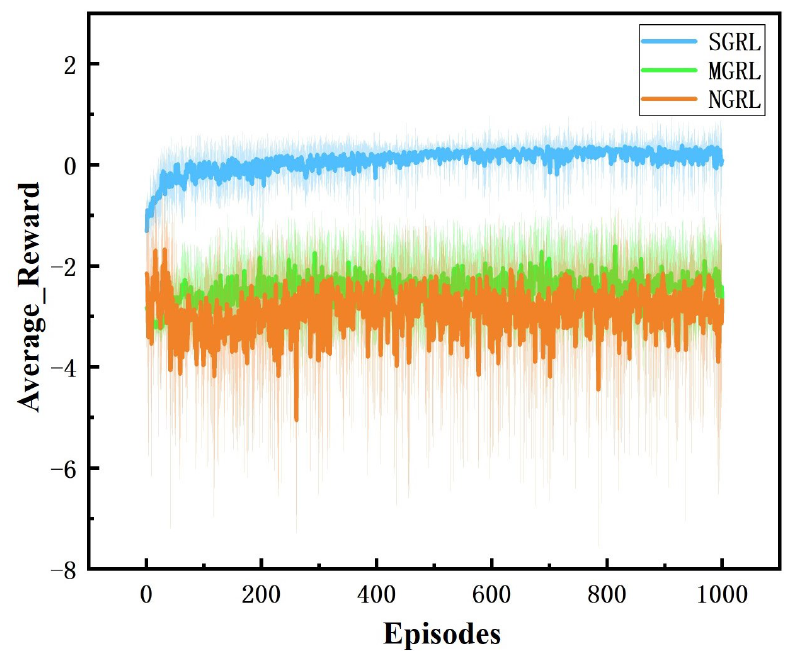
Figure 10. Diagram of average reward. This value is the average of each step reward